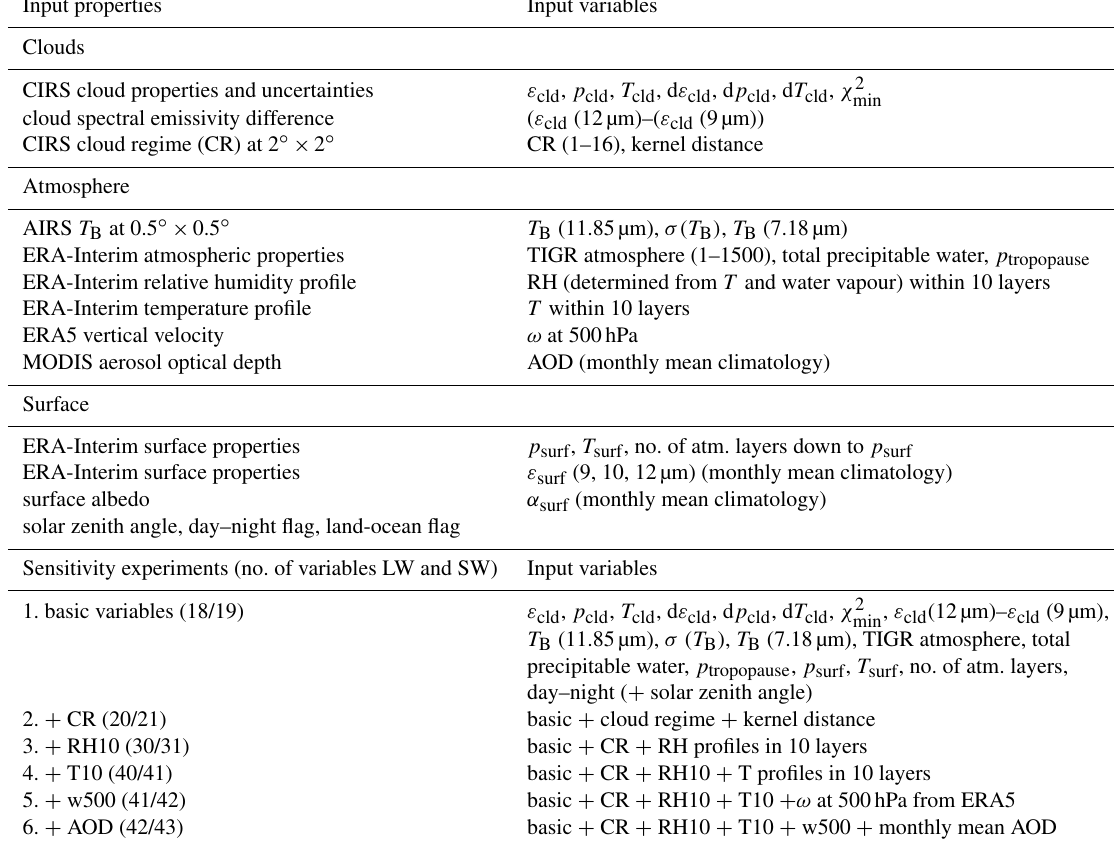
Table 1. List of input variables for the prediction of LW and SW heating rates and sensitivity experiments. Input properties